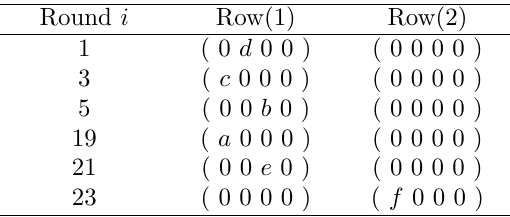
Table 2: The round tweakey differences ∆ tk i used in the key recovery